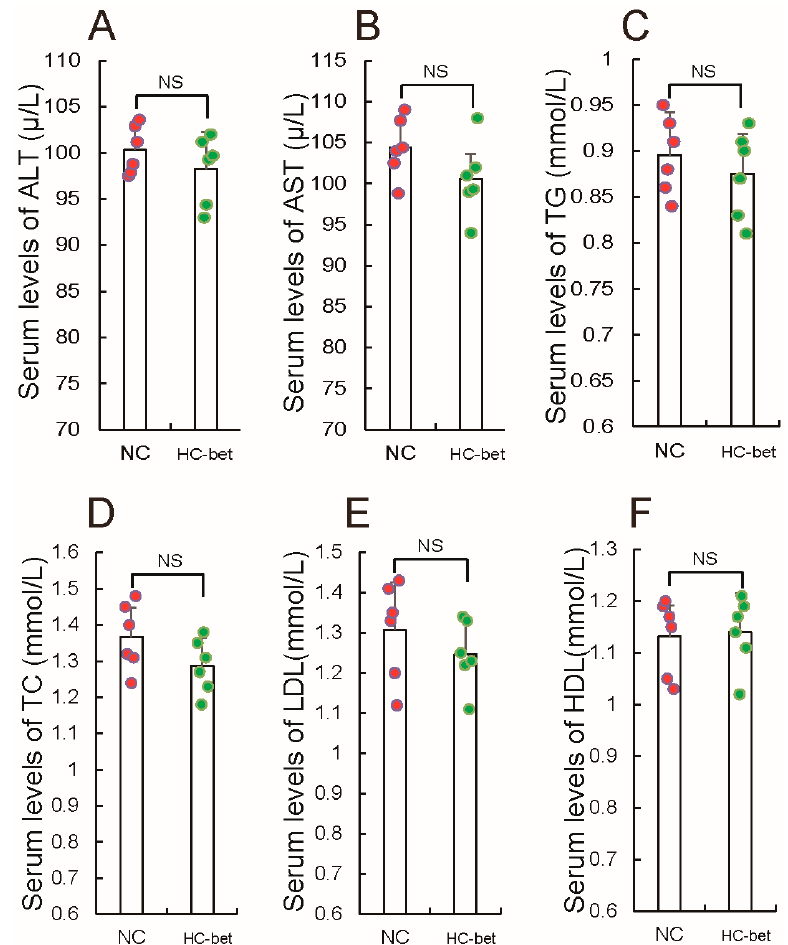
Figure 3. The effect of betaine supplementation on normal chow (NCW)-fed mice. NCW-fed mice were treated with 1% betaine in water (HC-bet) or without 1% betaine in water (NC), then serum levels of ( A ) alanine transaminase (ALT); ( B ) aspartate aminotransferase (AST); ( C ) triglycerides (TG); ( D ) cholesterol (TC); ( E ) low-density lipoprotein (LDL); ( F ) high-density lipoprotein (HDL) were tested. All results are presented as means ± standard error (SE). n = 6. * p < 0.05; ** p < 0.01; NS, no significance; NC, mice fed with normal chow; HC-bet, mice fed with normal chow and betaine.